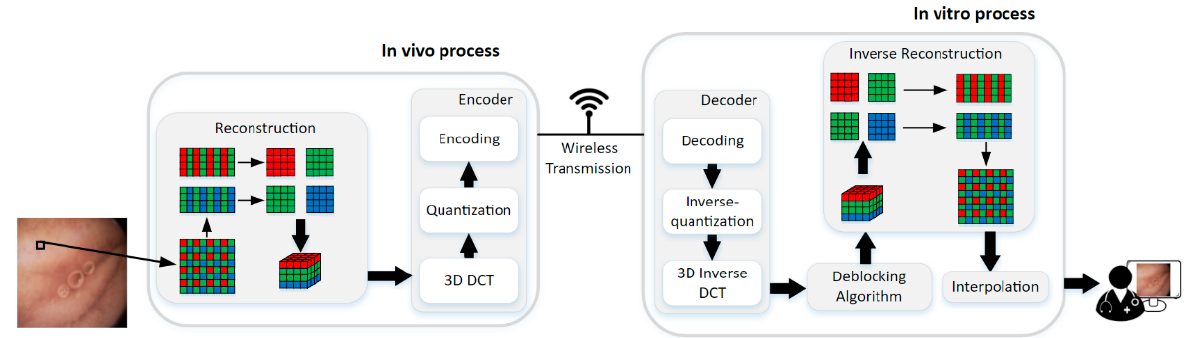
Figure 3. The framework of the proposed compression method.